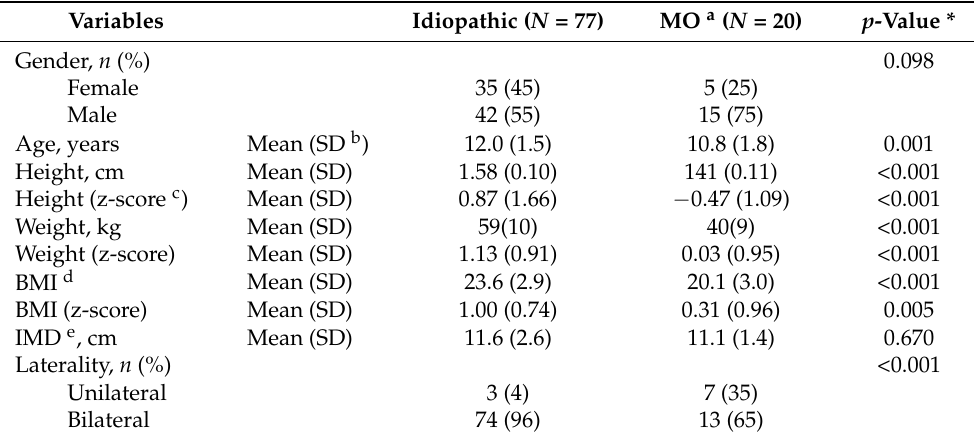
Table 1. Patients’ characteristics at